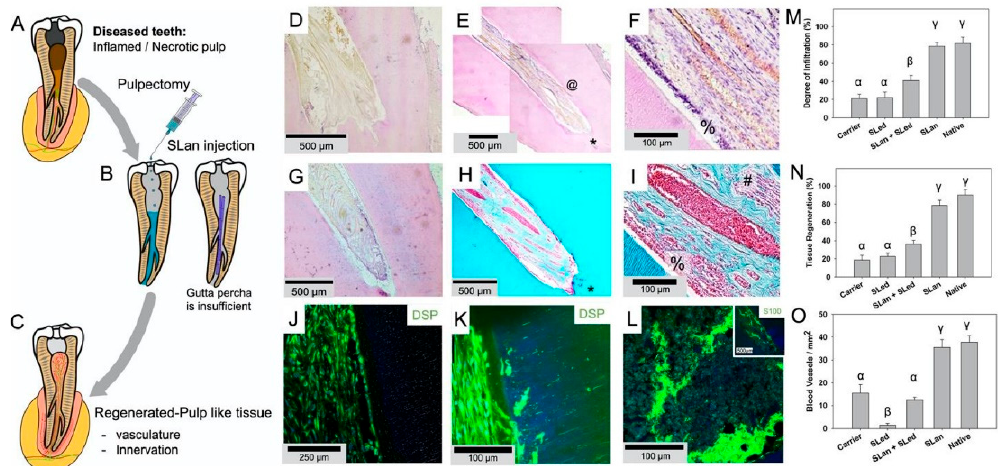
Figure 3. The application of hydrogel in dental root canals in animal model (Figure 3 is adapted from reference [55] ). (A) Caries and trauma may lead to the inflammation and necrosis of the pulp. (B) After pulpectomy, implantation of injectable angiogenic SLan hydrogels help regenerate (C) vas- cularized pulp-like soft tissue in 28 days. In a canine pulpectomy model, disorganized blood clots form for over-instrumentation carrier filled (sucrose-HBSS) control (D). H&E staining of tooth roots of SLan filled teeth showed rapid infiltration of cells and tissue (E), and within crevices in the canal space (@), along with an odontoblast-like layer in apposition to the dentin wall (F-%). Control den- tinogenic SLed hydrogels lead to disorganized tissue (G). Trichrome staining of SLan implants re- veals blood vessels (H, I) with collagen deposition (blue); and an odontoblast-like layer (I- %) which stains with dental sialoprotein (DSP) (J) with cytoplasmic protrusions into dentinal tubules (K). S100+ Nerve bundles (Trichrome I-#) were regenerated along the length of the canal (L and inset). (M) Degree of infiltration, (N) degree of tissue regeneration, and (O) densities of blood vessels were similar for SLan and native teeth but significantly greater than controls.